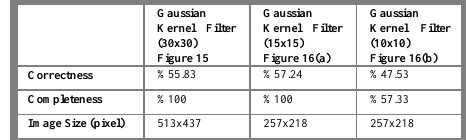
Table 5: Evaluation of Different Size of Gaussian Kernel Filter for image in figure 15 and down sampled version in figure 16 3.2.2 Initialization